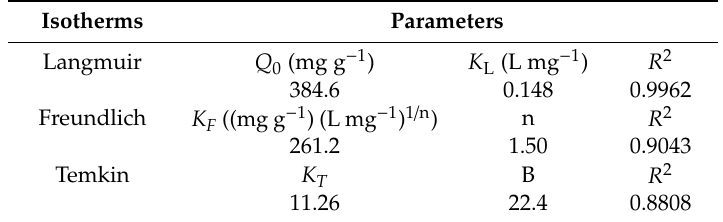
Figure 8. Linear regression of MB on BSNC-800-4 at 298 K with Langmuir isotherm model, Freundlich isotherm model and Temkin isotherm model. Table 2. Isotherm parameters for the adsorption of MB onto BSNC-800-4 at 298 K.